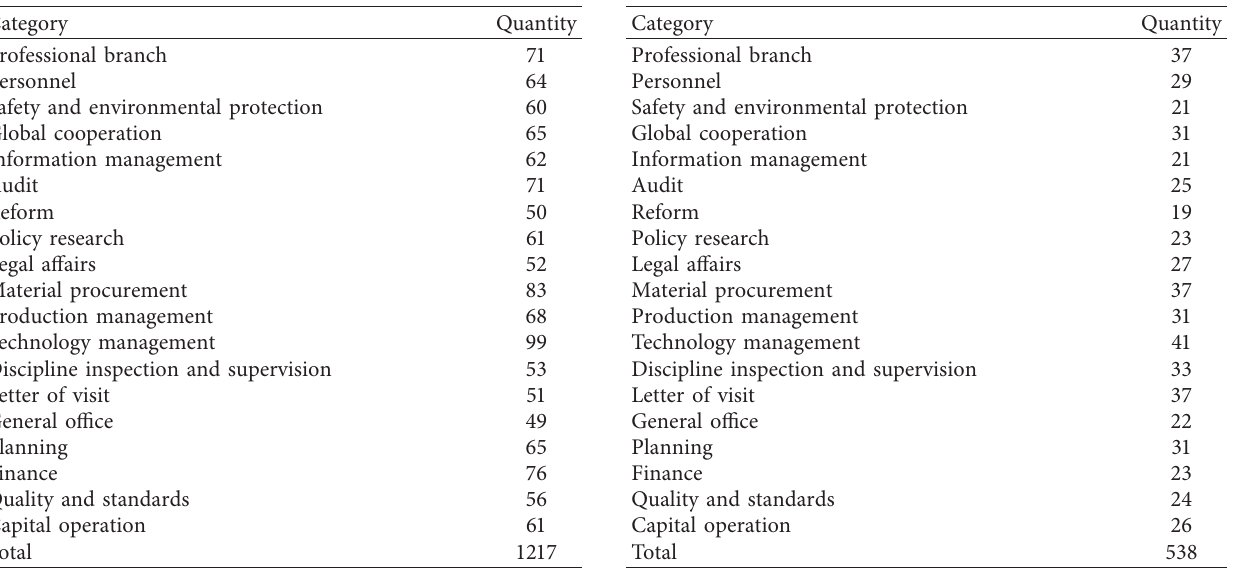
Figure 8: The relationship between training samples of different classification categories and accuracy and time. (a) Accuracy line graph. (b) Modeling time diagram. Table 1: Number of files in each training set. Table 2: Number of files in each test